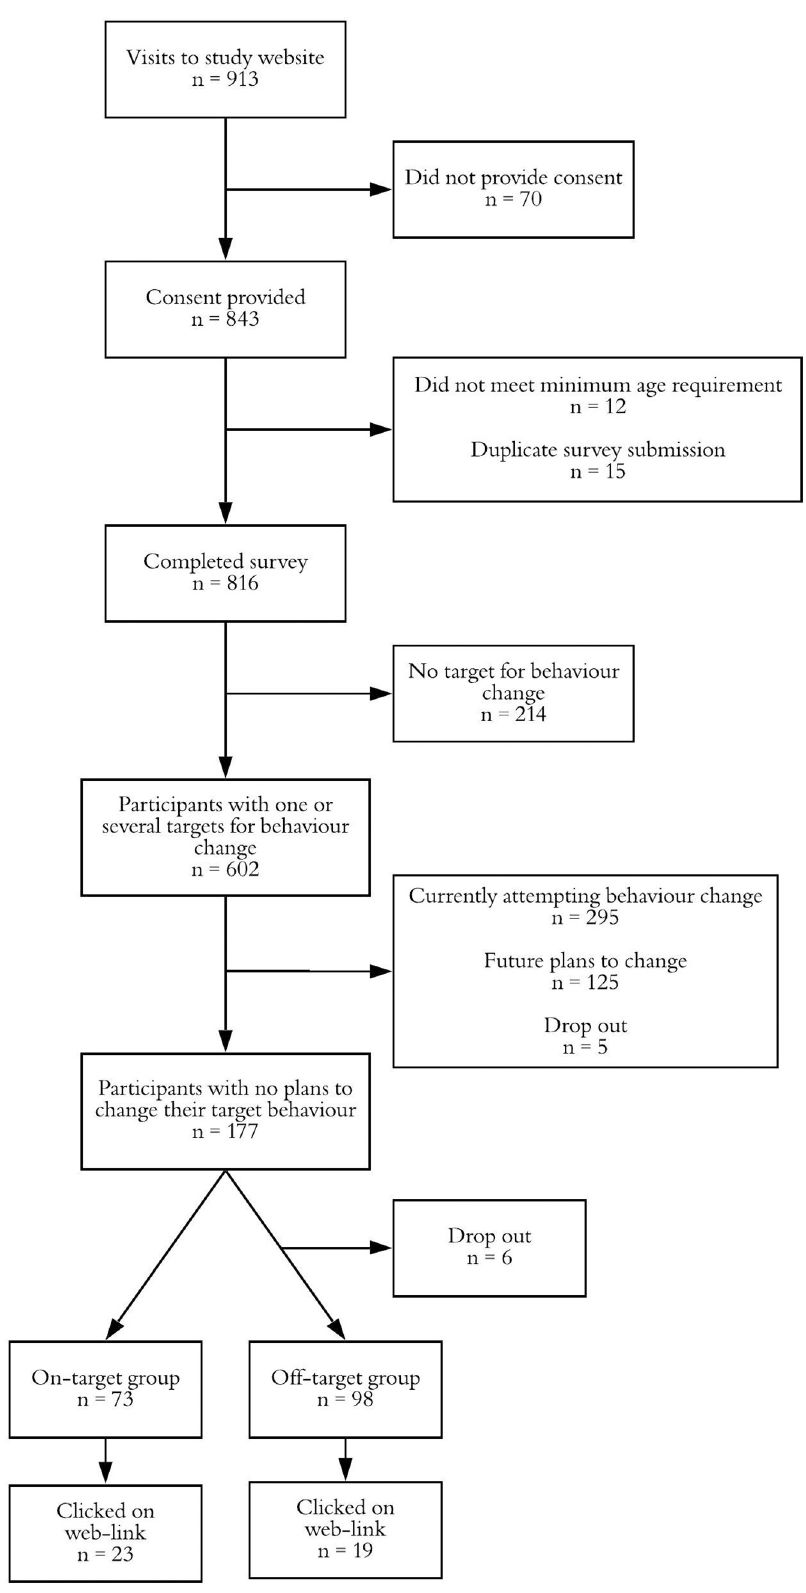
Fig 1. Procedural flow and participant allocation to the intervention